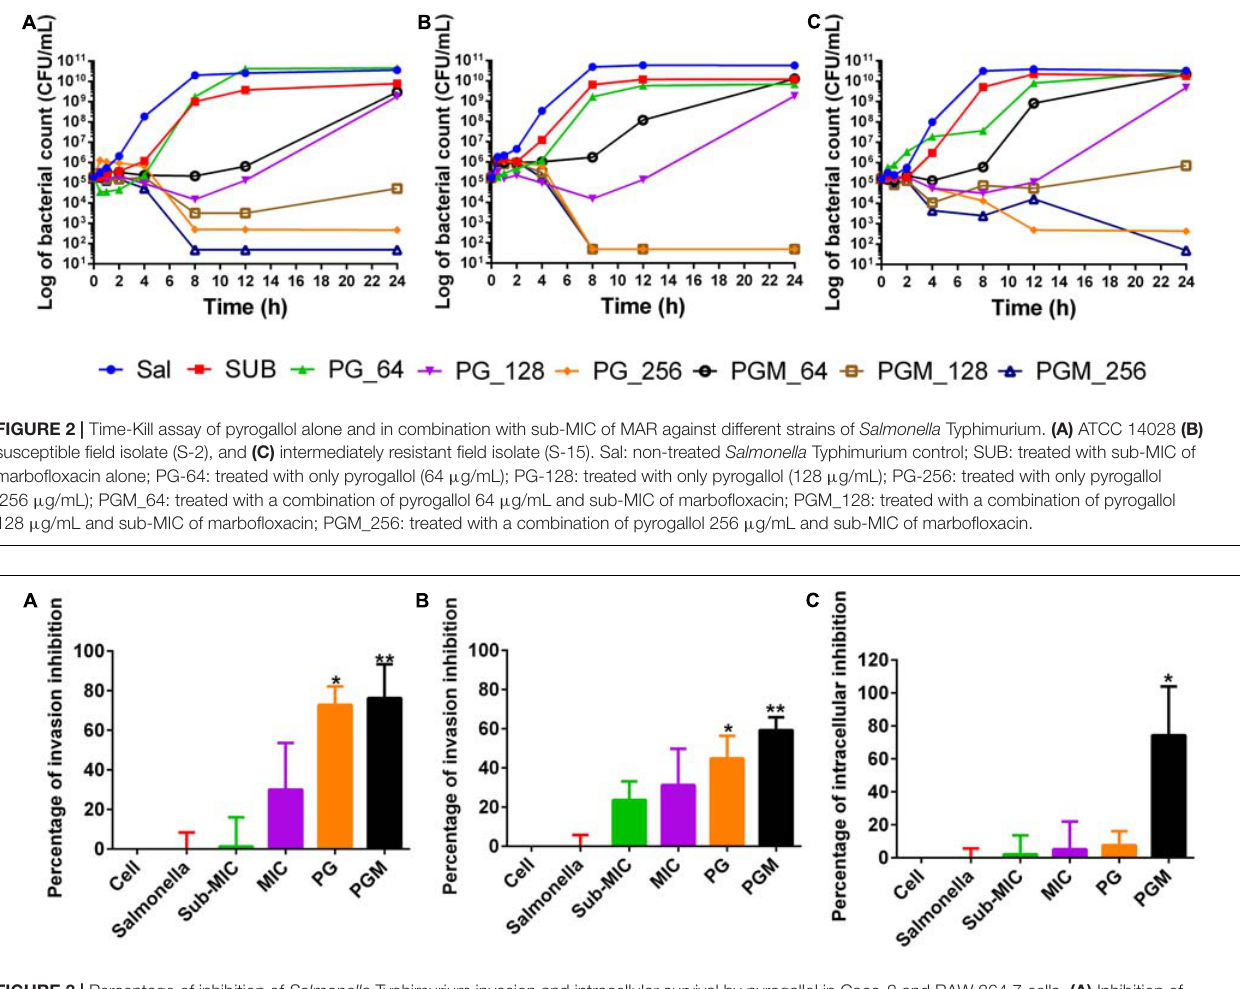
FIGURE 3 | Percentage of inhibition of Salmonella Typhimurium invasion and intracellular survival by pyrogallol in Caco-2 and RAW 264.7 cells. (A) Inhibition of Salmonella Typhimurium invasion in Caco-2 cells; (B) inhibition of Salmonella Typhimurium invasion in RAW 264.7 cells and (C) Inhibition of intracellular survival of Salmonella Typhimurium by pyrogallol in RAW 246.7 cells. Cell – non-infected cells; Sal – infected with Salmonella Typhimurium but not treated; sub-MIC – infected with Salmonella Typhimurium and treated with sub-MIC of MAR alone; MIC – infected with Salmonella Typhimurium and treated with the MIC of MAR alone; PG – infected with Salmonella Typhimurium and treated with 30 µ g/mL of PG; PGM – infected with Salmonella Typhimurium and treated with a combination of 30 µ g/mL of PG and sub-MIC of MAR; * P < 0.05 and ** P <